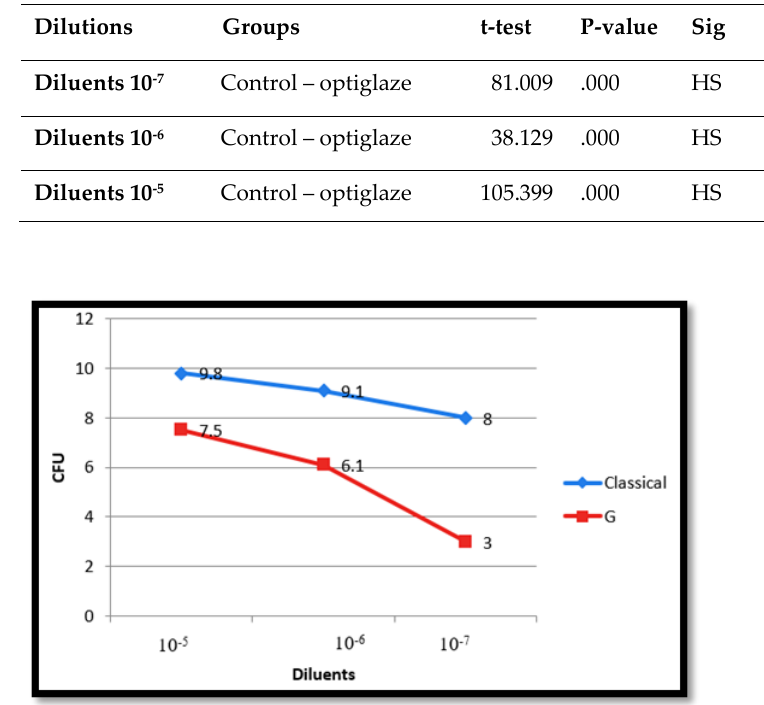
Figure 6: Effect of optiglaze on the viability count of Staphylococcus aureus in different dilution (CFU=colony form- ing